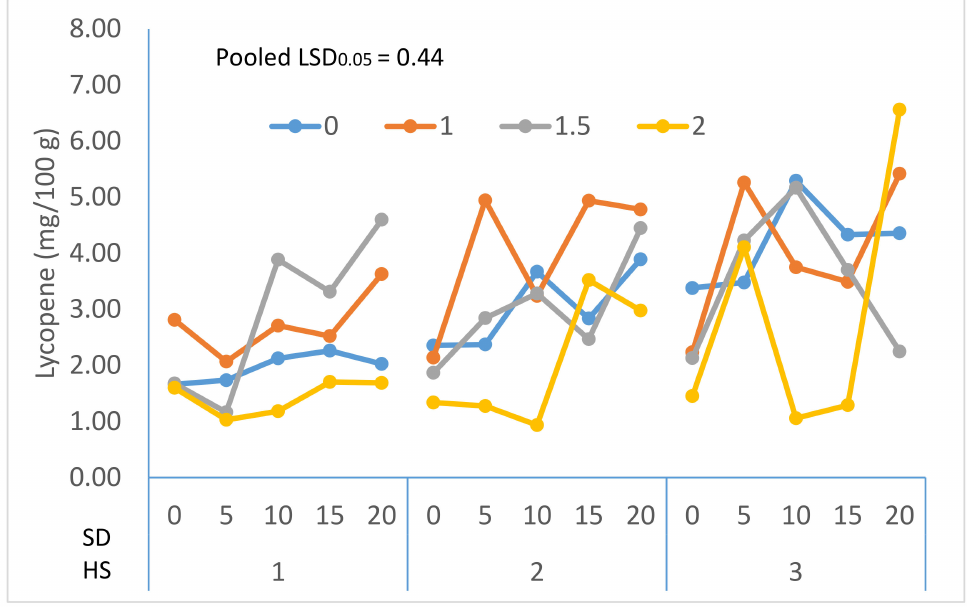
Figure 5. The interaction effects of CaCl 2 (0, 1%, 1.5%, and 2%, w / v ), harvesting stages (HS: 1 = green mature, 2 = breaker and 3 = half-ripe) and storage durations (SD: 0, 5, 10, 15 and 20 days) on lycopene content of tomato fruit stored at ambient temperature (28 ± 2 ◦ C and 75 ± 5% RH). Pooled LSD 0.05 =